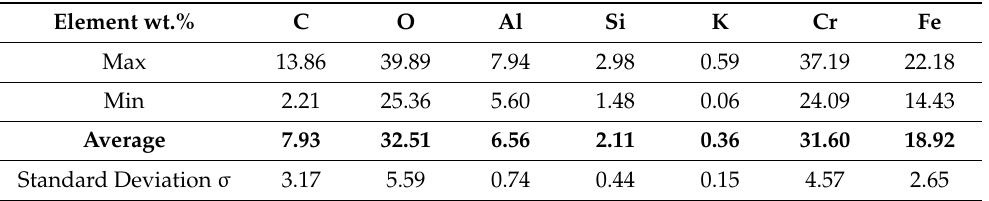
Table 6. Elemental wt.% contents of 15 min MR15M-reclaimed sand in the analysed area (in Figure 9b). Element